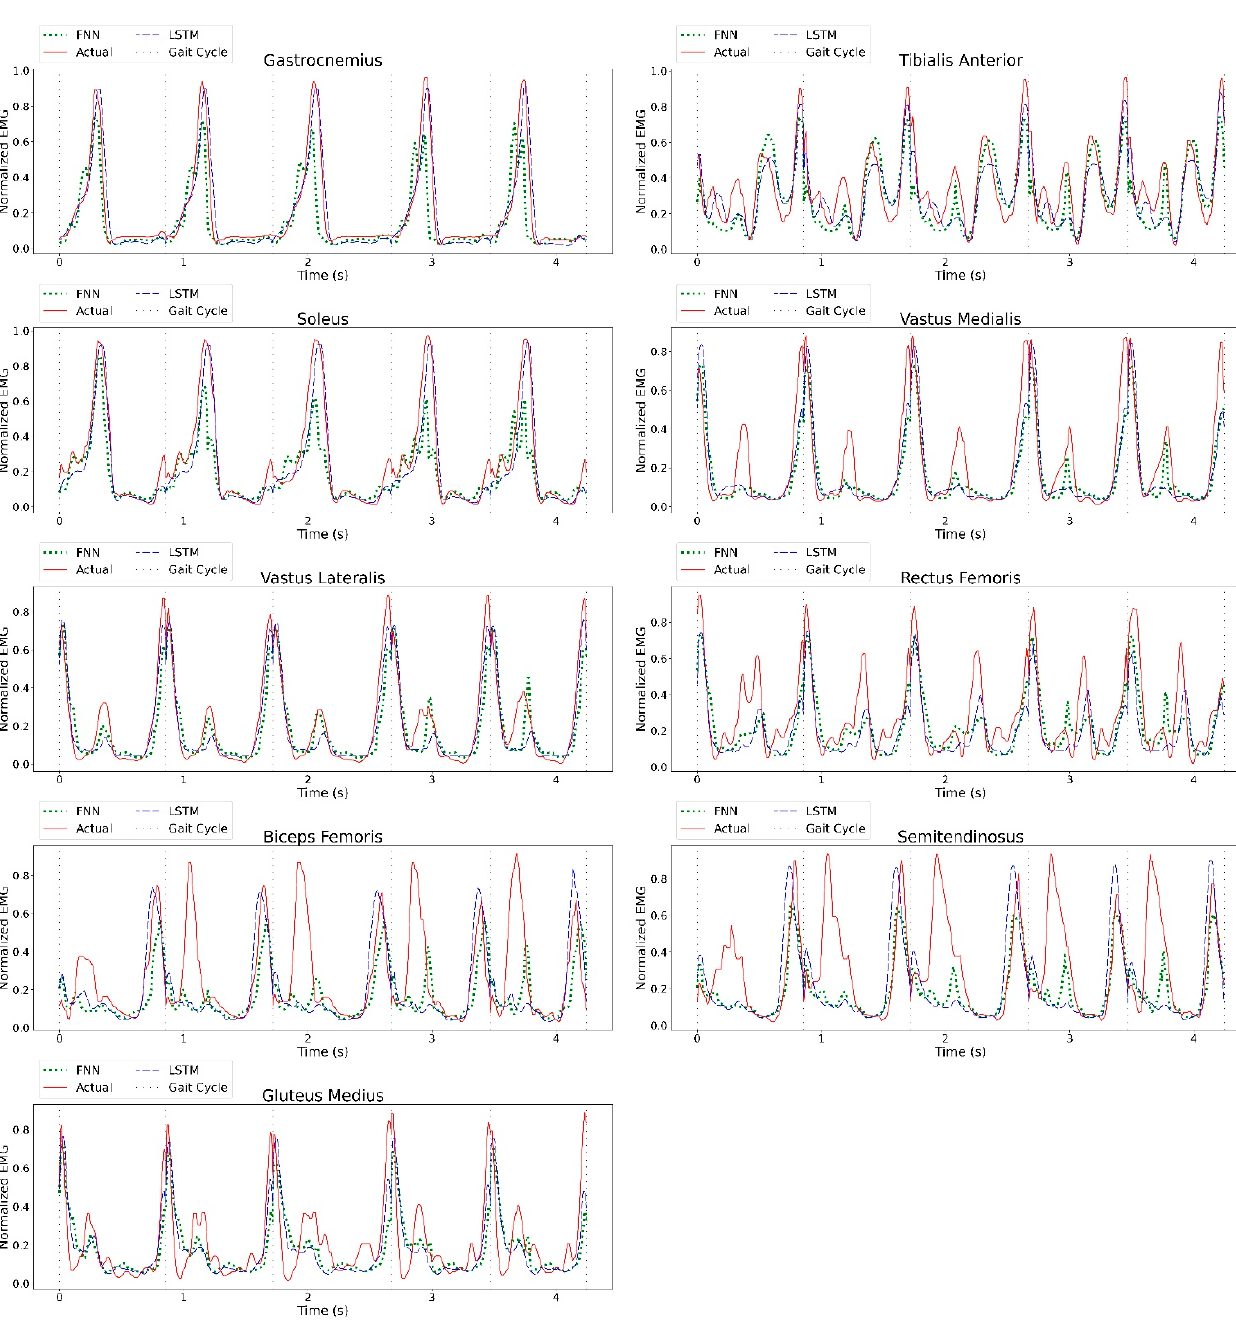
Figure A5. A plot of actual vs. predicted muscle activities of the unseen data (Sample B).